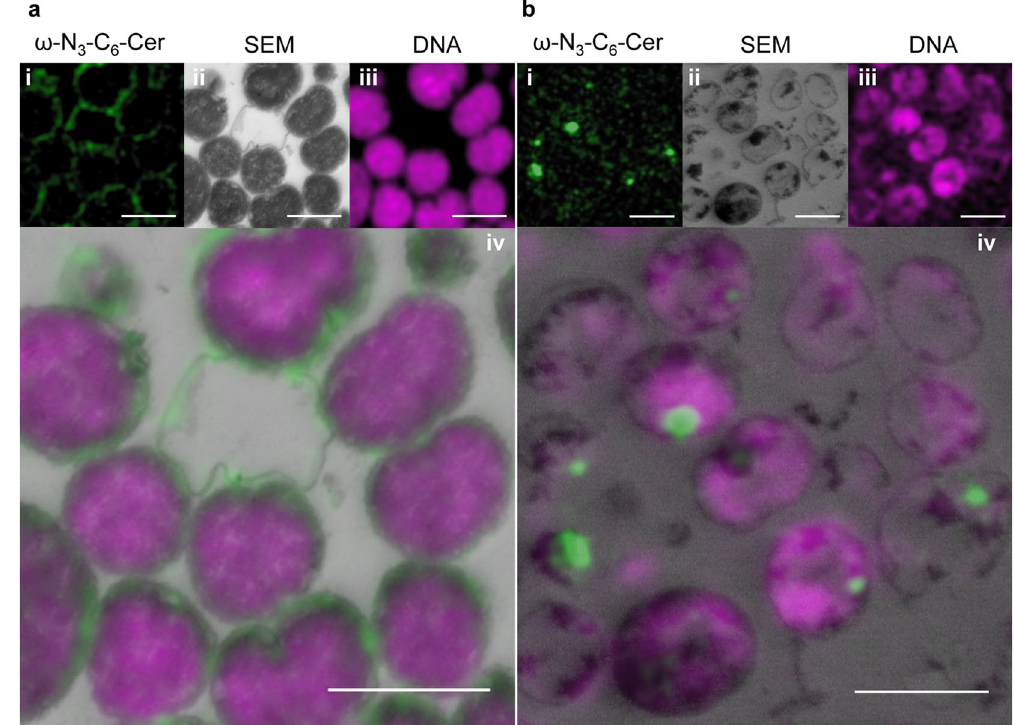
Figure 3. Click-AT-CLEM strategy reveals localization of ω-N 3 -C 6 -Ceramid in N. meningitidis . ( a , b ) Representative CLEM images of N. meningitidis treated with 0.1 × MBC ( a ) or 1 × MBC ( b ) of ω-N 3 -C 6 - ceramide. Upper rows show representative single images of the ω-N 3 -C 6 -ceramide [ω-N 3 -C 6 -Cer (green)] and DNA signal (magenta) taken with SIM ( i , iii ) and N. meningitidis image taken with SEM ( ii ). Final images after unbiased correlation are shown in ( iv ). Scale bars 1